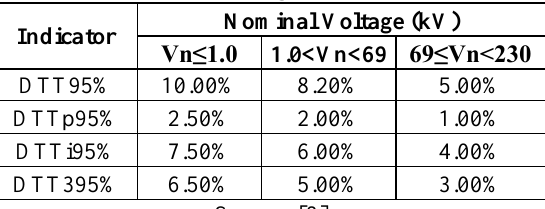
Table 1: Limits of harmonic distortions (in % of the fundamental